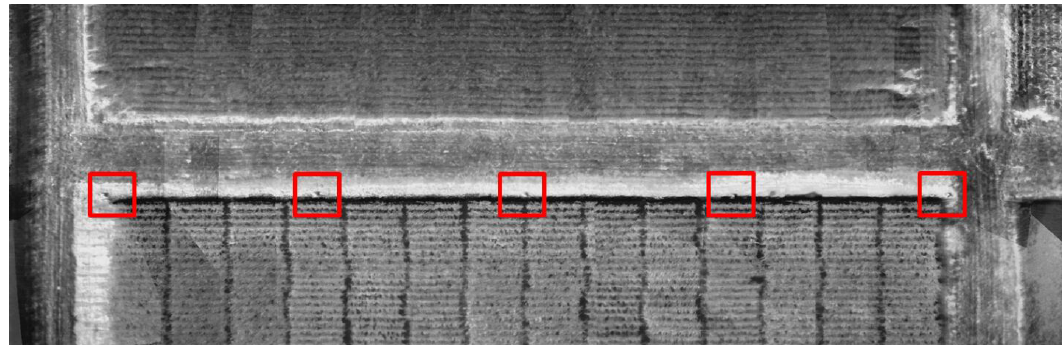
Figure 20. Orthophoto result from direct approach for FLIR thermal September 14th data collection (red boxes show the location of the check points, Orignal Image GSD ≈ 0.03 m